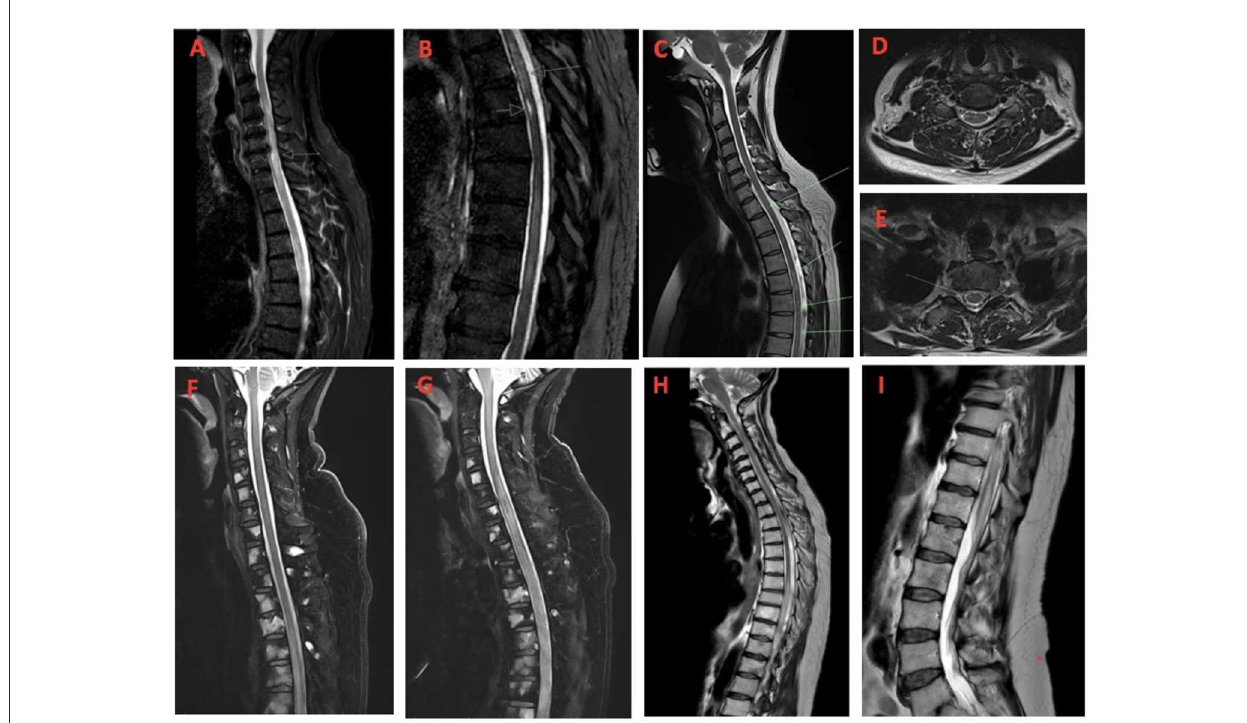
FIGURE1 (A, B) Case 1-Sagittal MRI demonstrating eccentric patchy abnormal intramedullary high STIR signal and enhancement within the spinal cord, most conspicuous at the level of C6/C7 and T5 (arrows); (C) Case 2-Sagittal and (D, E) axial MRI images showing longitudinally extensive abnormal T2 signal hyperintensity in the cord from T4/T5 to T12 with a faint focus of cord signal hyperintensity at C5/C6 and at T1/2; (F) Case 3-Sagittal MRI images demonstrating longitudinally extensive abnormal T2 signal hyperintensity in the mid-thoracic cord on initial presentation and (G) extending to involve the mid- to lower cervical spinal cord 2 weeks later; (H) Case 4-Sagittal MRI images demonstrating longitudinally extensive abnormal T2 signal hyperintensity from mid-thoracic cord T6/T7, extending to the conus medullaris (I)